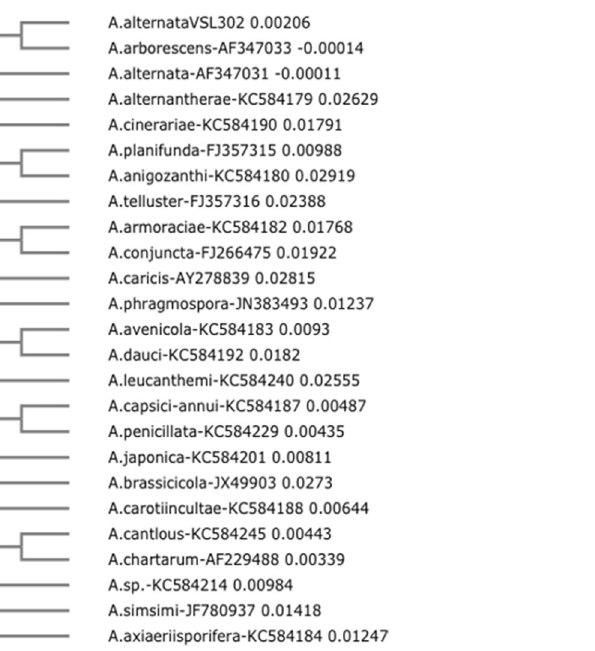
correspond to the genus and species Alternaria alternata ( A. arborescens AF347033 and A. alternata AF347031). The NJ tree was generated with the PAUP program using the neighbor-joining method. Numbers on branches indicate bootstrap values from an analysis of 1000 replicates.